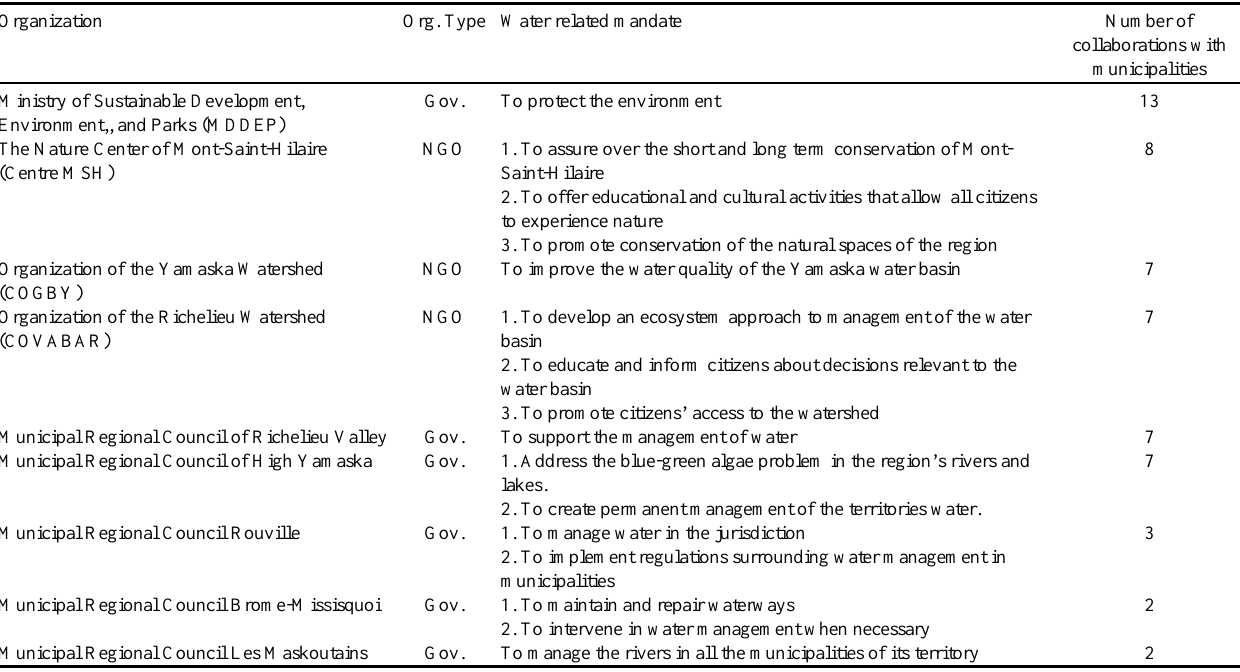
Table 2 . Main bridging organizations, their mandates, and